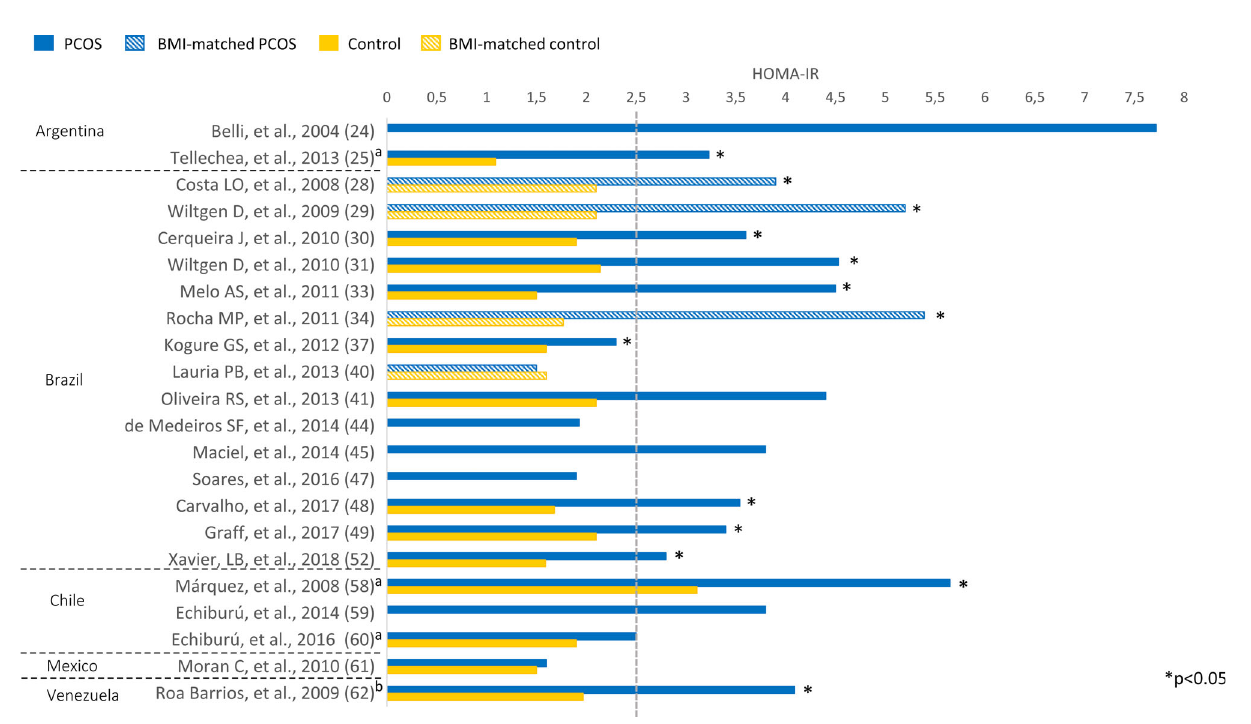
FIGURE 3 | HOMA-IR among Latin American women with PCOS and controls. Mean values. The “ x ” axis shows the name of studies and reference numbers (refer to the text). a PCOS diagnosis according to NIH criteria; b PCOS diagnosis de fi ned by the